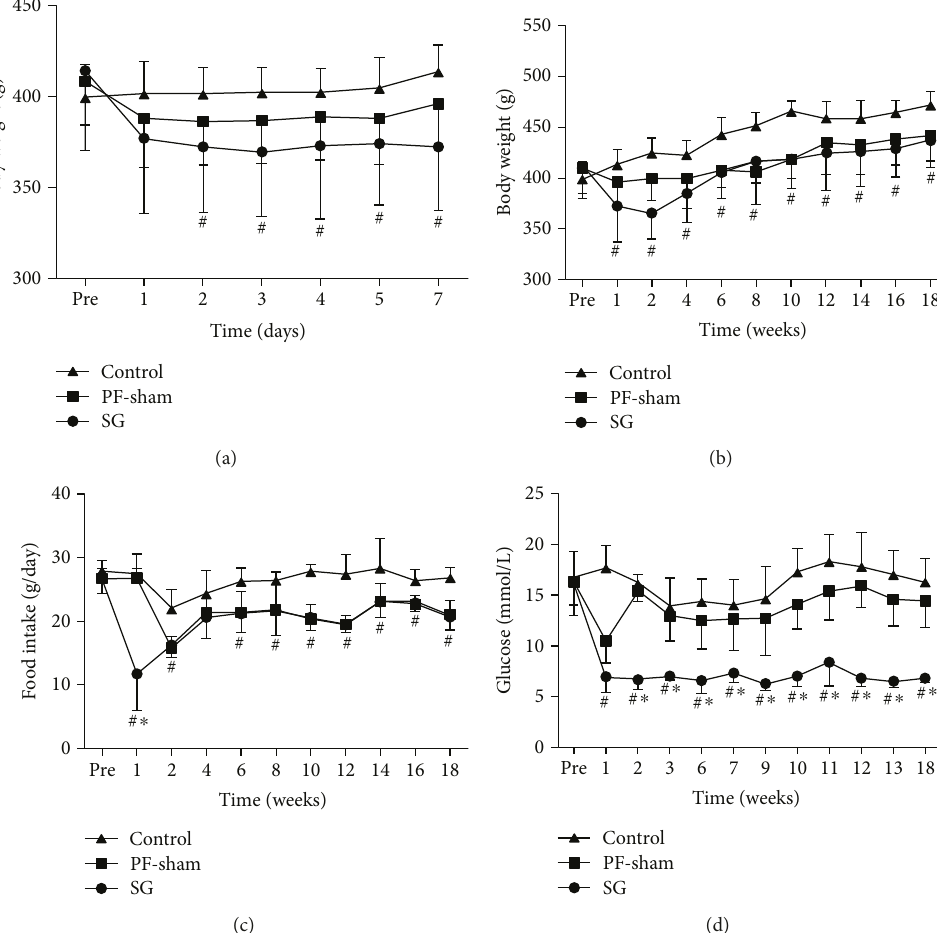
Figure 1: E ff ects of sleeve gastrectomy on food intake, body weight, and fasting glucose levels in GK rats. Line charts show body weights (a, b), food intake (c), and glucose (d). # P < 0 05 versus the controls; ∗ P < 0 05 versus